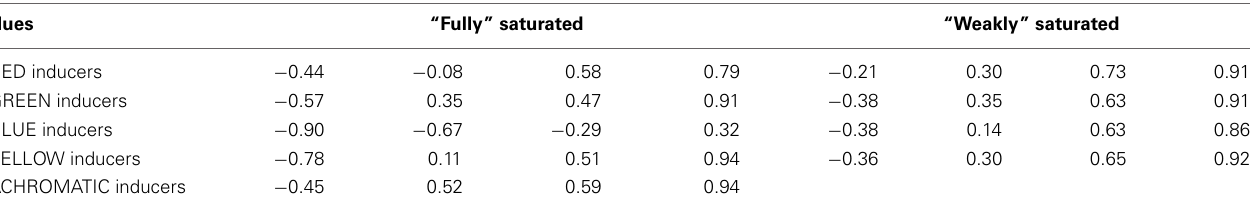
Table 2 | Michelson contrasts (four per hue and saturation level and four additional achromatic conditions) of the inducer-background